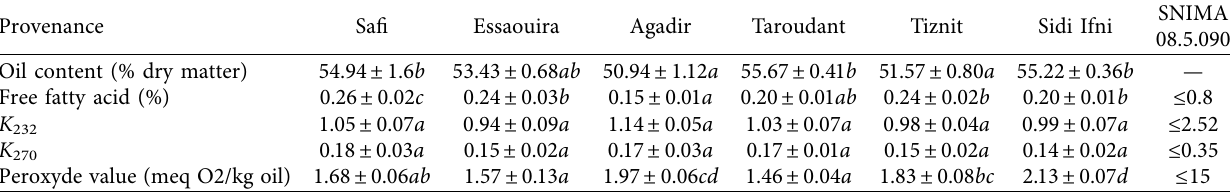
Table 2: Mean values and standard deviations of the oil content and quality parameters of Argan oil from six provenances. Provenance